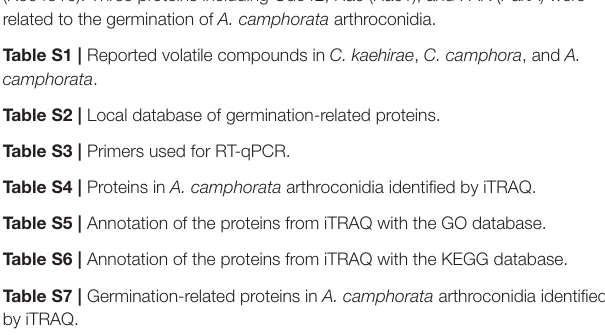
Figure S1 | A schematic diagram of the bioinformatics analysis for iTRAQ. Figure S2 | Distribution of 16 germination-related proteins in KEGG pathway. (A) Chemokine signaling pathway (Ko04062). Six proteins including Cdc42, Rac